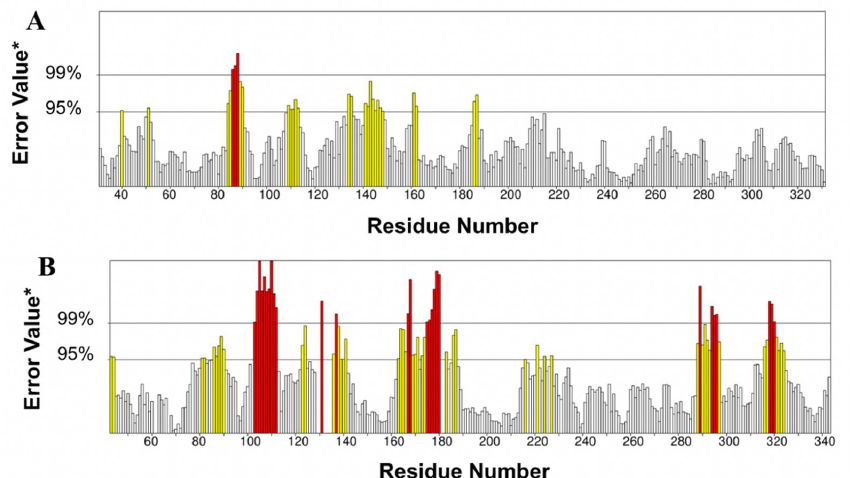
Figure 6. ERRAT plots showing an overall quality factor of 89.1799% in ( A ) TLR4 and 75.8092% in ( B ) p50. * On the error axis, the two line are drawn to indicate the confidence with which it is possible to reject regions that exceed that error value.